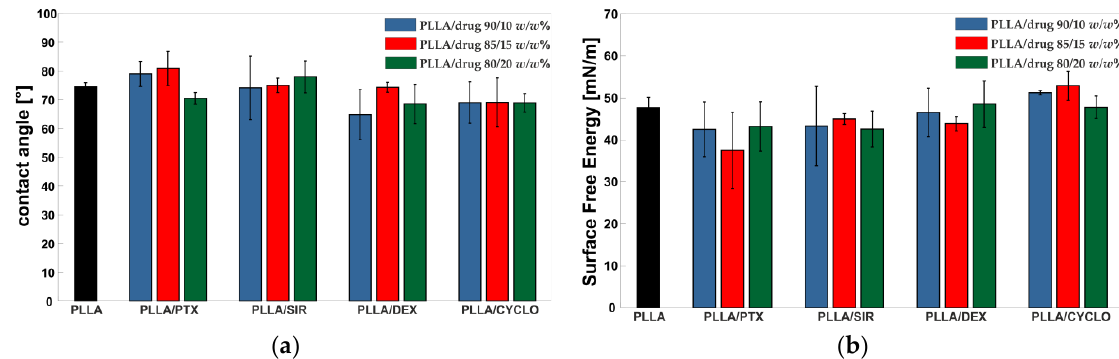
Figure 5. Water contact angle and surface free energy data for drug incorporated PLLA films (mean values for n = 3 with droplet angles taken each from both sides of the drops are shown). Statistical analysis (two-tailed t -test) did not show any significant differences ( p < 0.05) of contact angle values and SFE values of drug incorporated PLLA films when compared to pure PLLA reference.